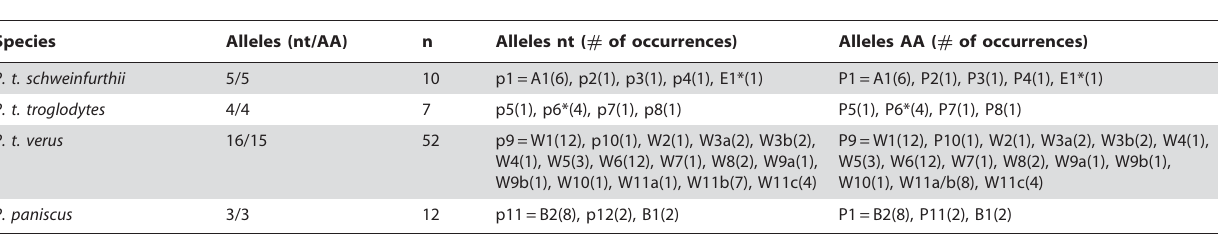
Table 1. Distribution of alleles according to